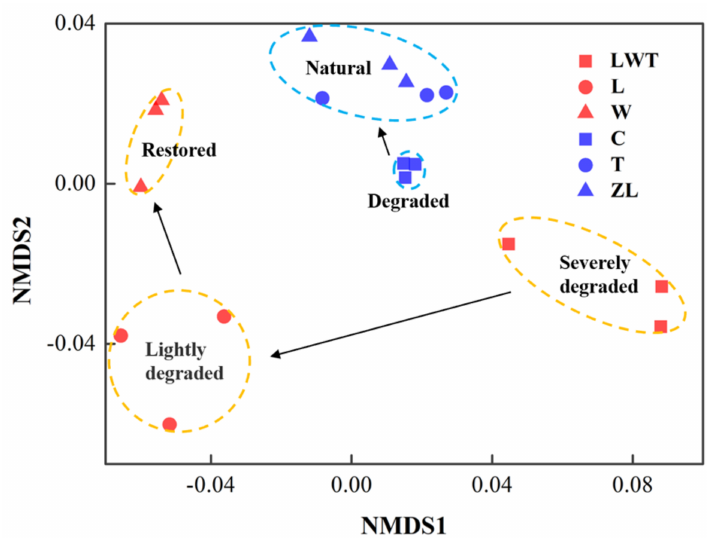
Figure 8. NMDS analysis based on the results of the GeoChip microarray showing functional microbial gene abundance. The red and blue symbols represent selected samples from the Phragmites and Carex sites, respectively, and the black arrows indicate a functional shift in microbial composition in different wetland